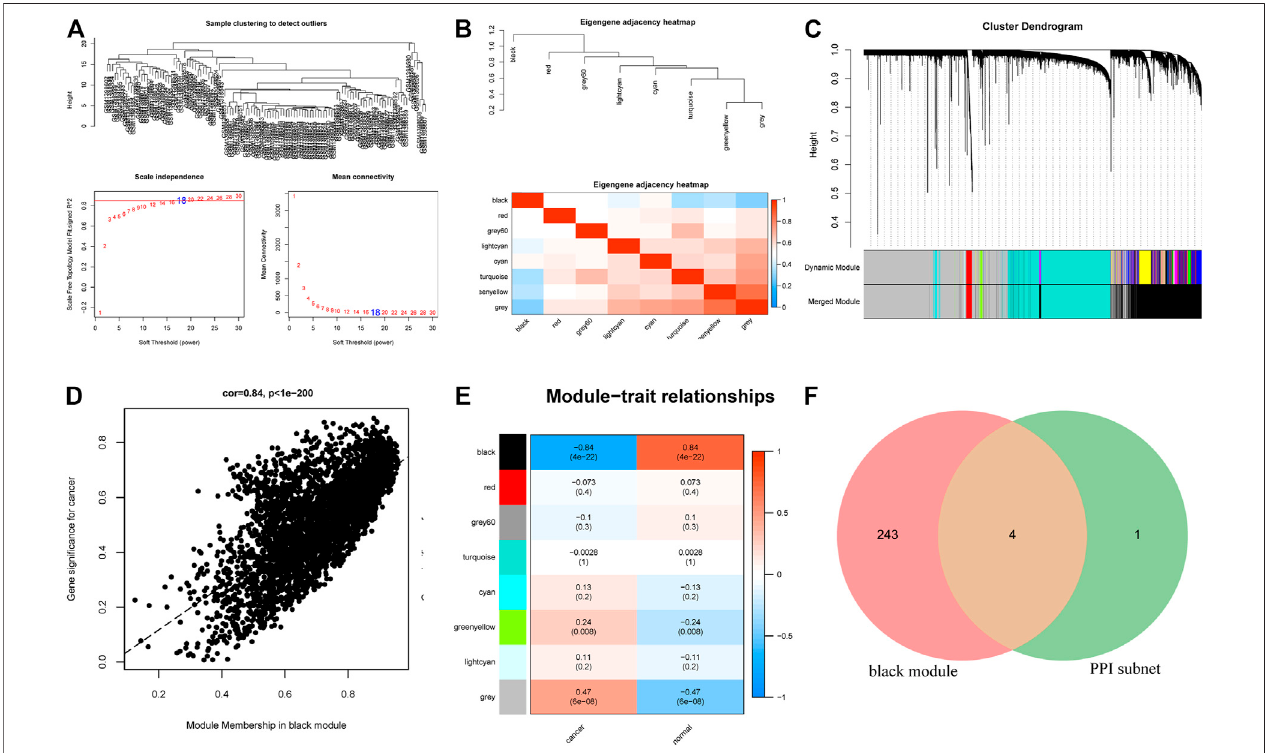
FIGURE 4 | (A) Sample clustering results, soft threshold results and soft threshold and average connectivity. (B) The clustering relationship between WGCNA modules and modules. The upper part is the clustering tree between modules, and the lower part is the clustering heatmap between modules. (C) Dendrogram of all differentially expressed genes clustered based on a dissimilarity measure. (D) Correlation analysis between cancer and the black module. (E) Correlation analysis of phenotypeandeachmodule. (F) VenndiagramshowingtheoverlappingmRNAsbetweenthemRNAsintheWGCNAhubmodulesandthemRNAsinthePPIcore